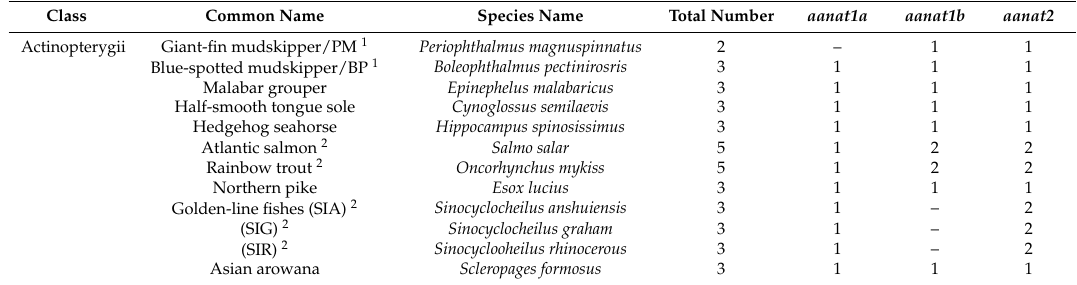
Table 2. The copy number of aanat genes from the fishes sequenced by our lab or collaborators.